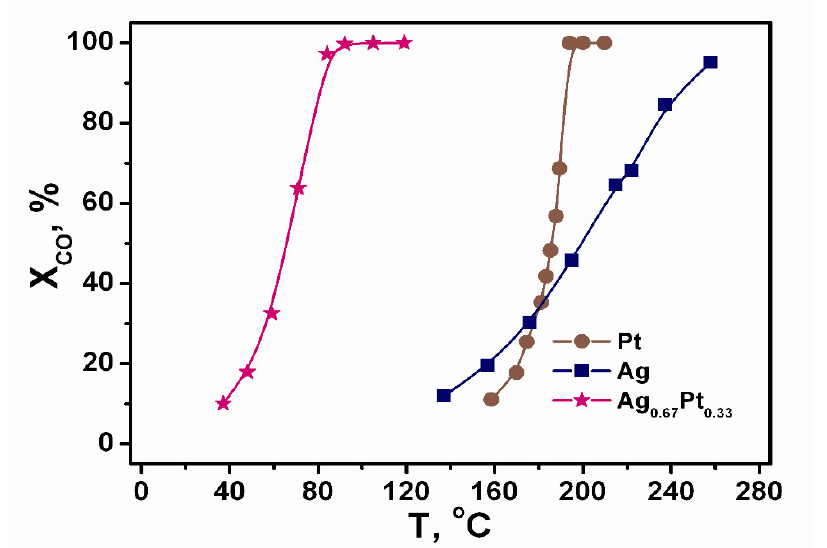
Figure 10. The temperature dependences of CO conversion (X CO ) for CO TOX over the Pt, Ag, and Ag 0.67 Pt 0.33 nano-powders. Feed gas composition (vol.%): 1.0 CO, 1.0 O 2 with He as balance. WHSV: 80 000 cm 3 g −1 h −1 (STP).